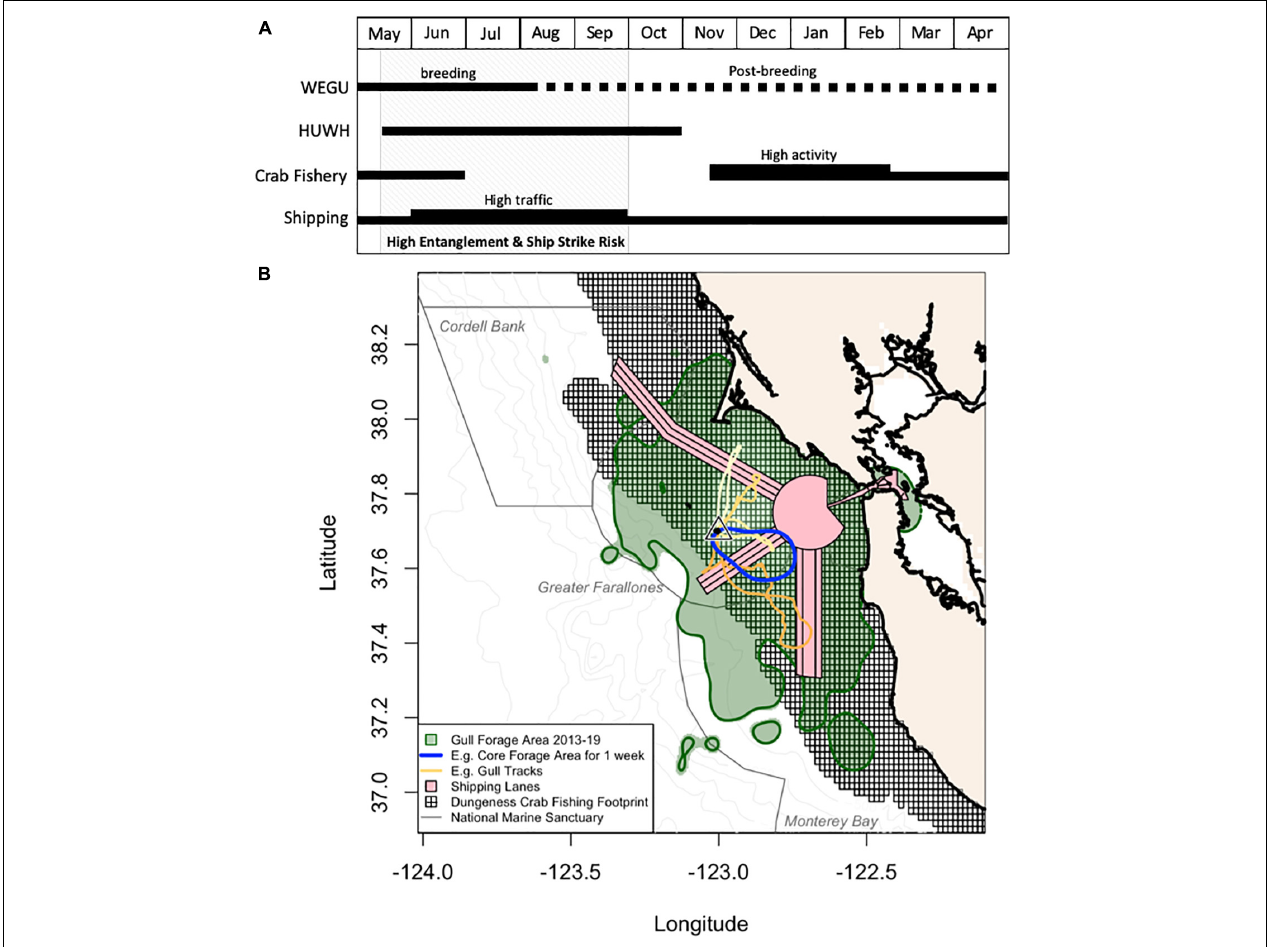
FIGURE 6 | Temporal and spatial overlap of western gulls (WEGU), humpback whales (HUWH), the Dungeness crab fishery, and shipping traffic in central California. (A) Phenology of the WEGU annual cycle at Southeast Farallon Island (black triangle) and HUWH presence in central California. After the gull breeding period, many birds remain in the Greater Farallones region occasionally visiting their colony. The Dungeness crab fishery operates from November to June with a peak in November—February. Shipping traffic outside of the San Francisco Bay is present year-round with a peak in the summer (June—September). Whale entanglement and ship strike risk occurs roughly from May to November (depending on whale arrival and departure dates), with the highest risk period between May and September (gray shading). (B) An example of a gull tracking visualization that could exist on an indicator dashboard highlighting: shipping lanes, the footprint of the crab fishery ( < 180 m), and gull foraging metrics including habitat use over 2013–2019 [95% kernel density estimate (KDE)], core habitat space over a 1-week period (50% KDE), and four examples of foraging trips. Also shown are three National Marine Sanctuary borders and bathymetry